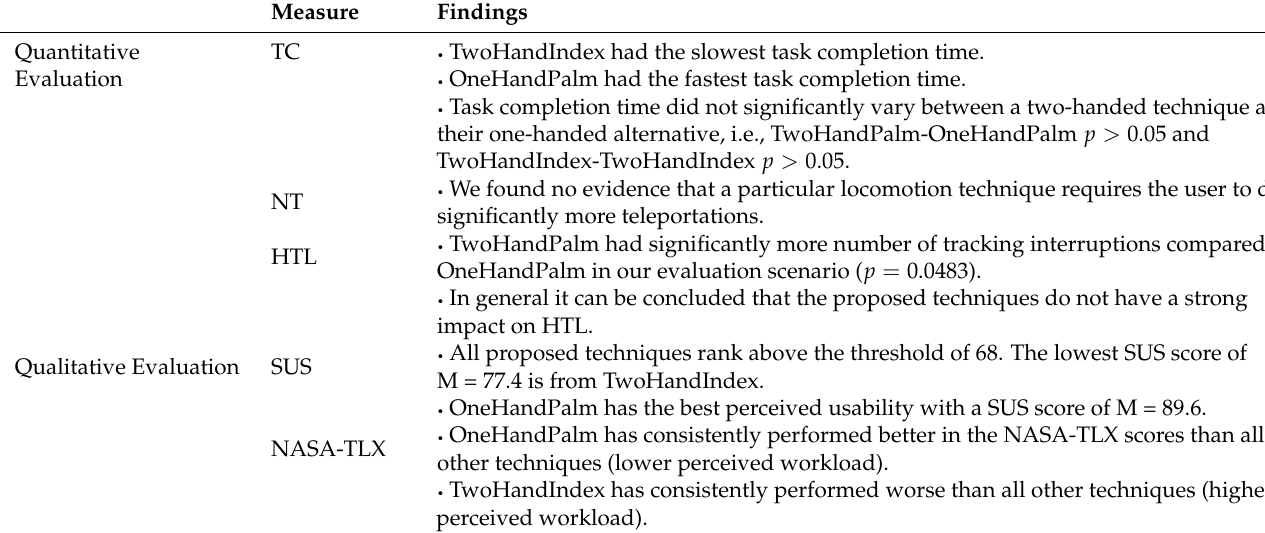
Table 2. Summary of our findings during the user study. The task completion time (TC), number of teleportations (NT), and the number of times the hand tracking was lost (HTL) are shown. The scores from the System Usability Scale (SUS) and NASA Task Load Index (NASA-TLX) are